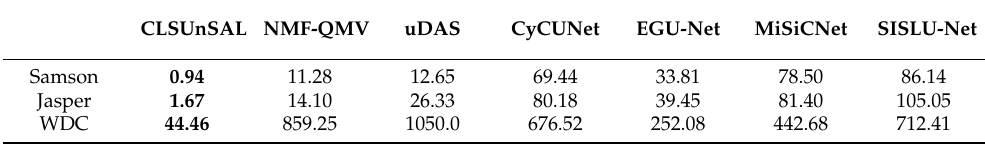
Table 11. The processing time (in seconds) of each method on the real dataset. (The optimal results are